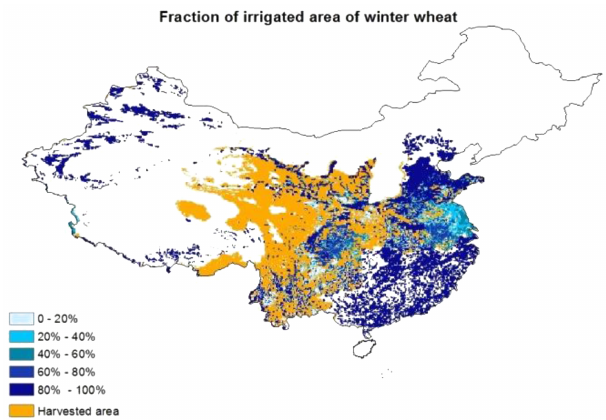
Figure 1. Harvested winter wheat areas in China in the year 2000 and fractions of the harvested areas irrigated. Data source: Port- mann et al.